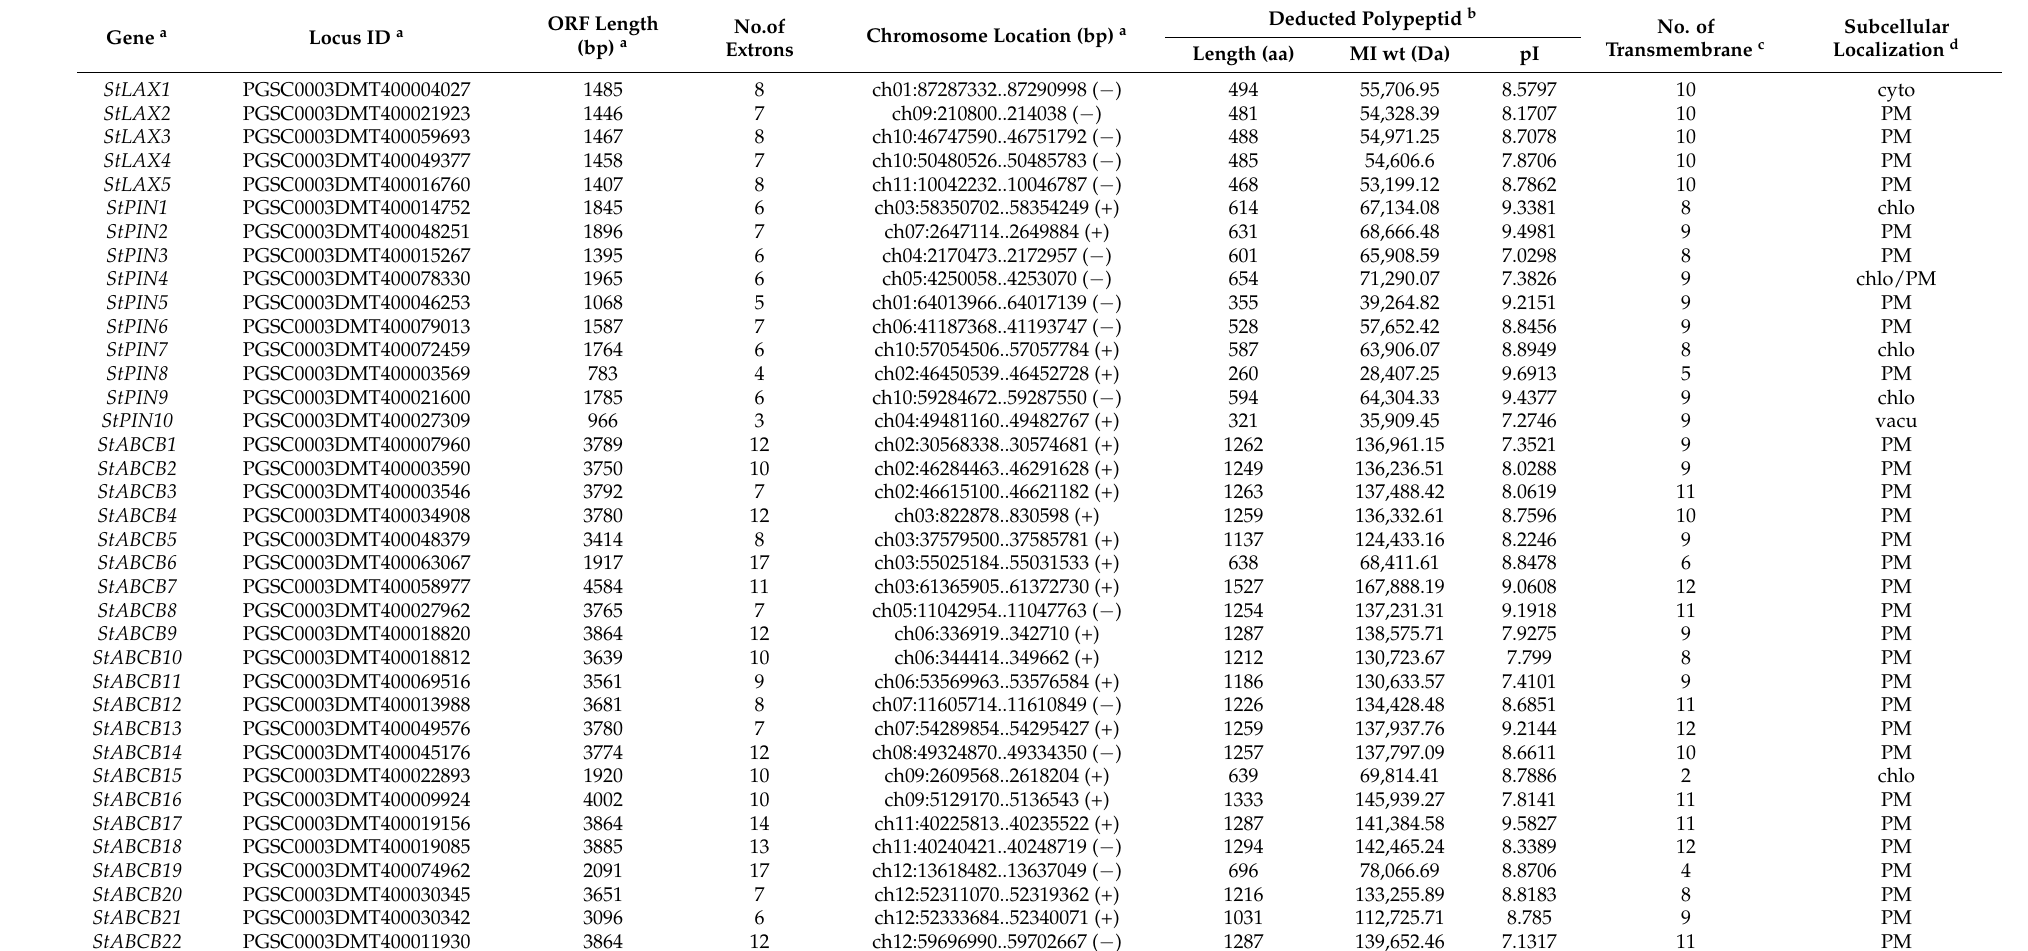
Table 1. Information on StLAX, StPIN, and StABCB genes and properties of the deduced proteins in potato ( Solanum tuberosum